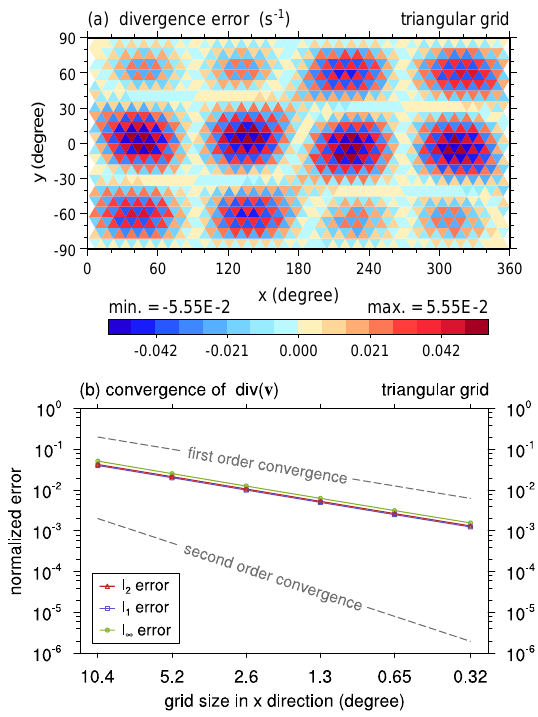
Fig. 4. (a) Numerical error of the cell-averaged divergence of the velocity field defined by Eq. (11), calculated using Eq. (6) on a pla- nar triangular grid with 10.4 ◦ resolution in the x-direction. (b) The l 1 , l 2 and l ∞ error norms at different resolutions. The discrete diver- gence is calculated by first evaluating Eq. (11) at edge centers then applying operator (6). Numerical error is computed with respect to cell